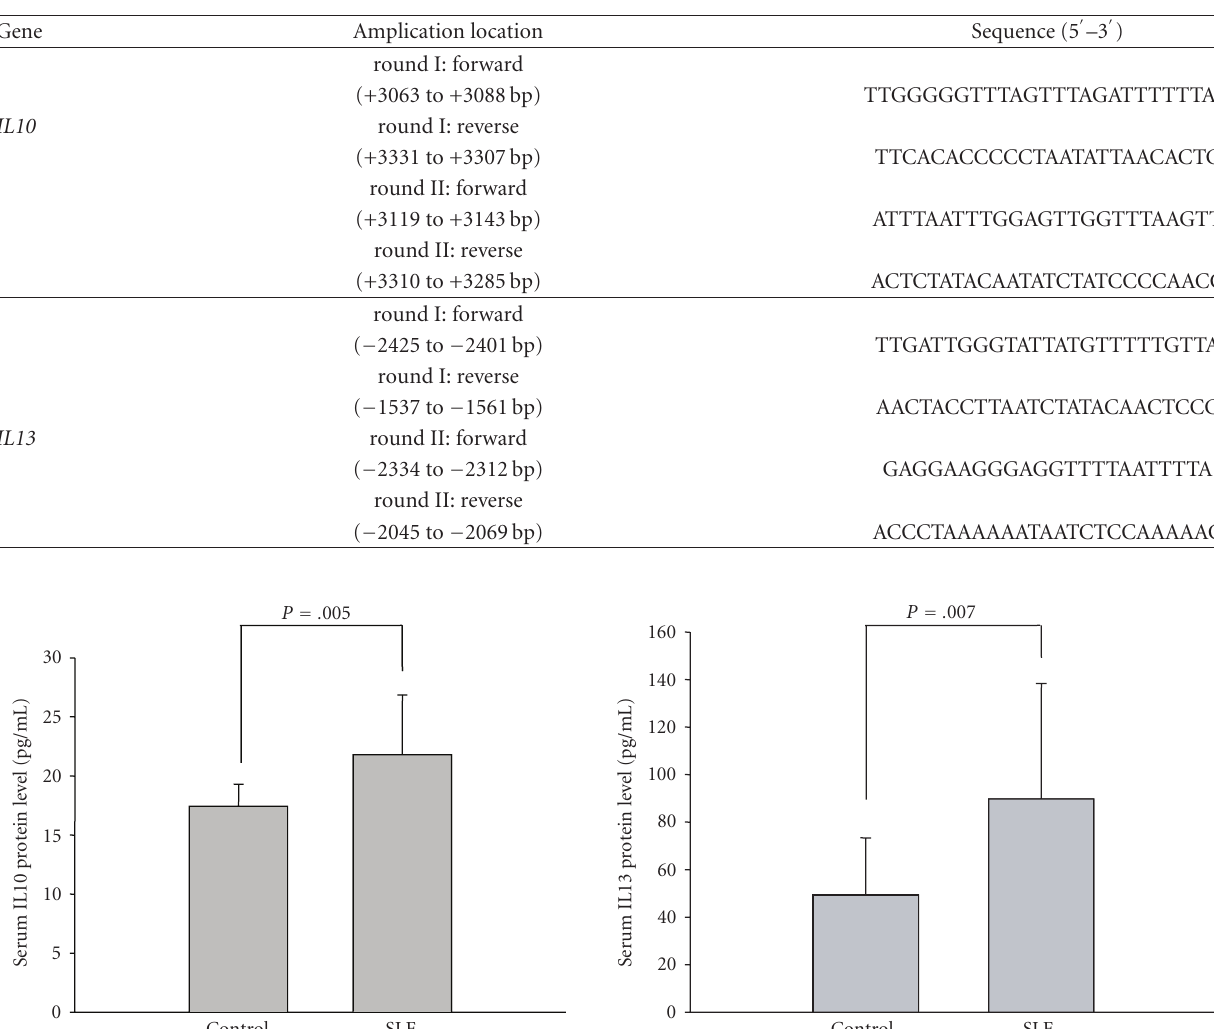
Table 2: Nest-PCR primers for Bisulfite sequencing.